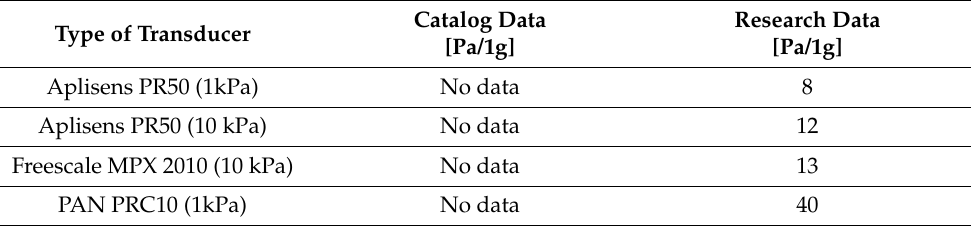
Table 1. Summary for several types of transducers and the influence of catalog and tested static acceleration [18,19,24].